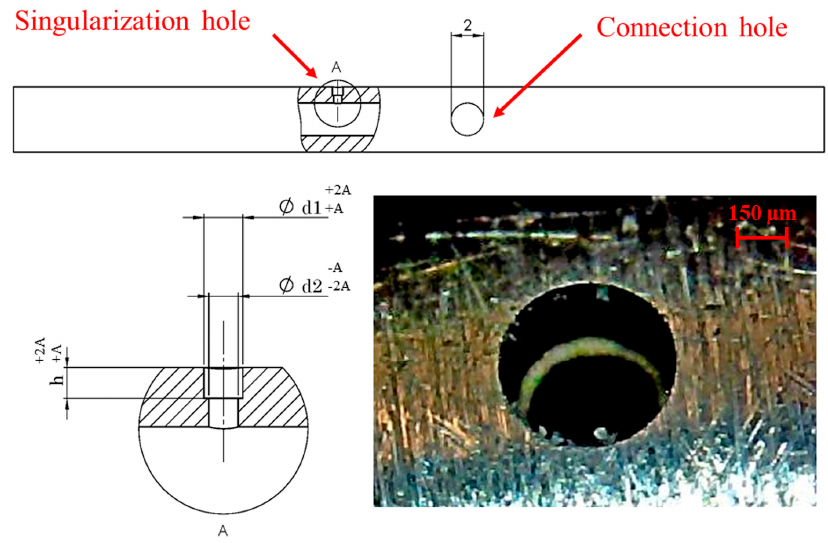
Rotating shaft: characteristic dimensions and detailed view of the manufactured singularization hole. Table 1. Singularization hole main dimensions according to the different manufacturing tolerances of the micro-spheres (solder balls: alloy: 63Sn–37Pb series eutectic composition).